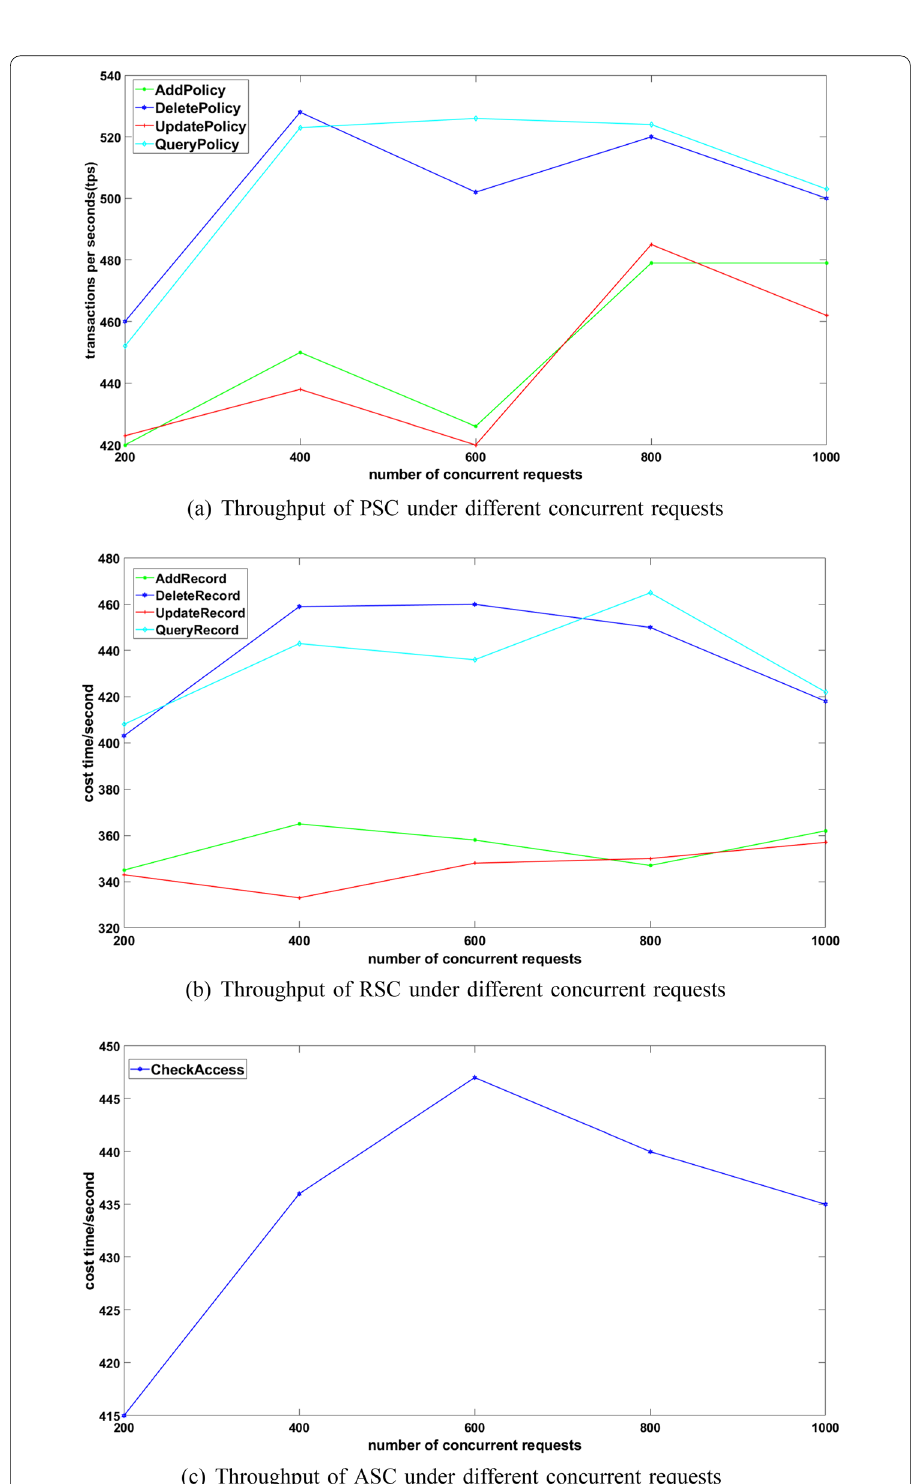
Fig. 15 Throughput under different concurrent